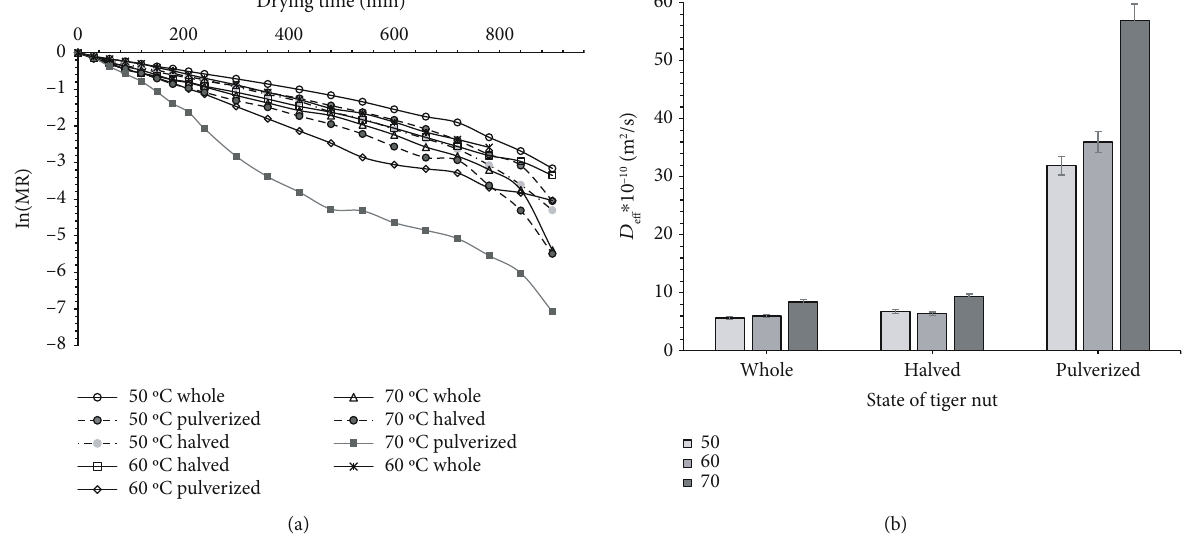
Figure 2: Variation of In(MR) against drying time and the e ff ective moisture di ff usivity ( D